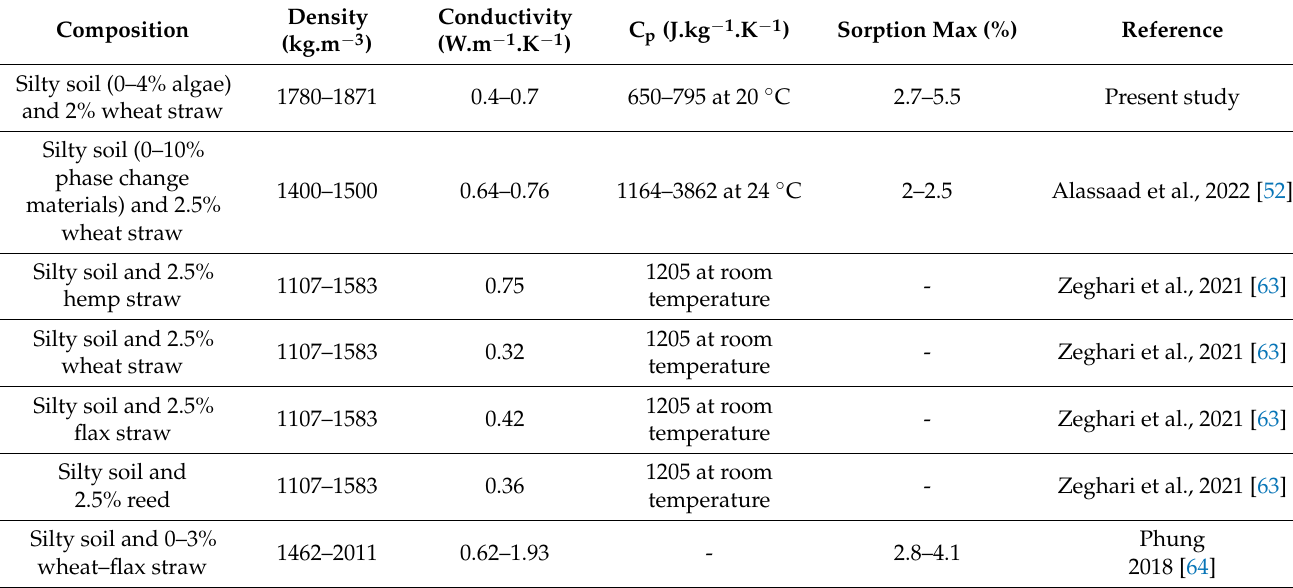
Table 9. Hygrothermal properties of different soil–fiber